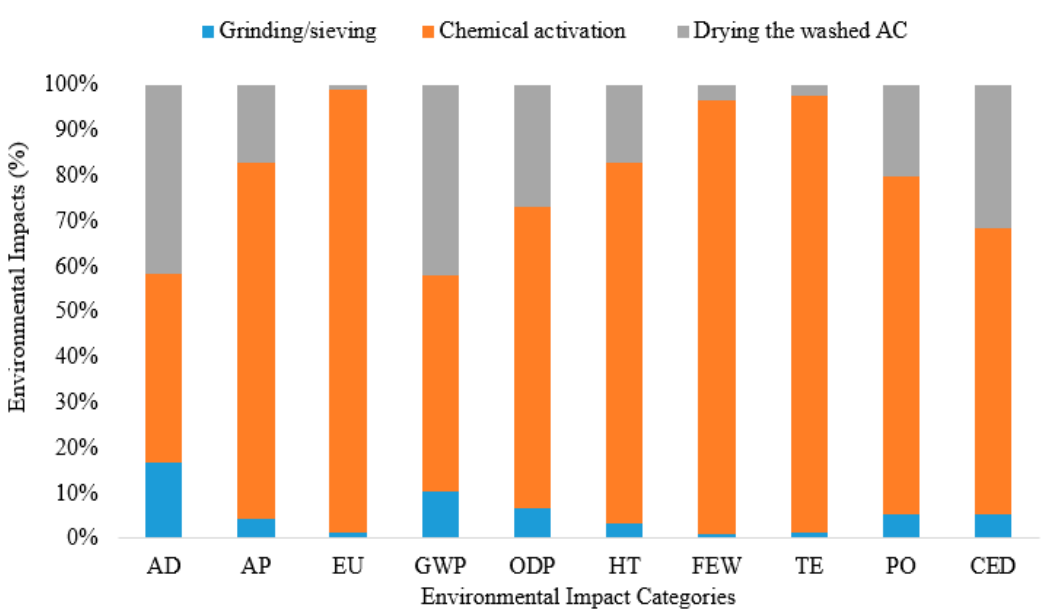
Figure 6. Environmental impact of AC production process from olive trees.